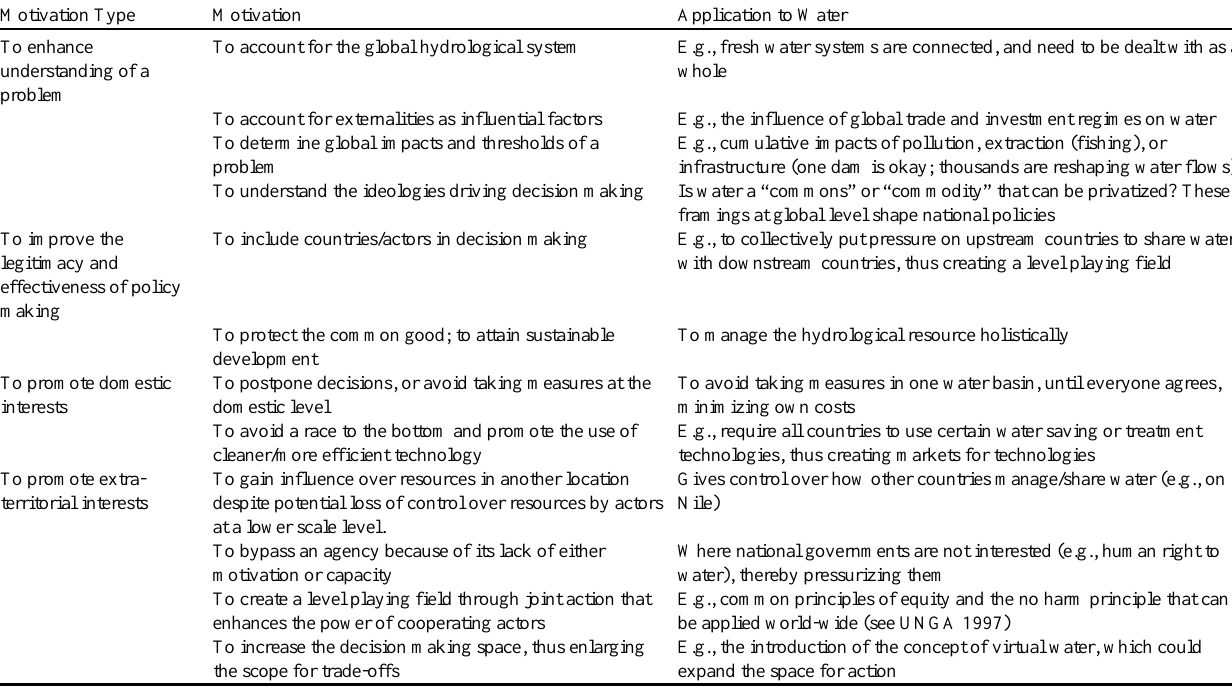
Table 3 . Reasons for scaling up